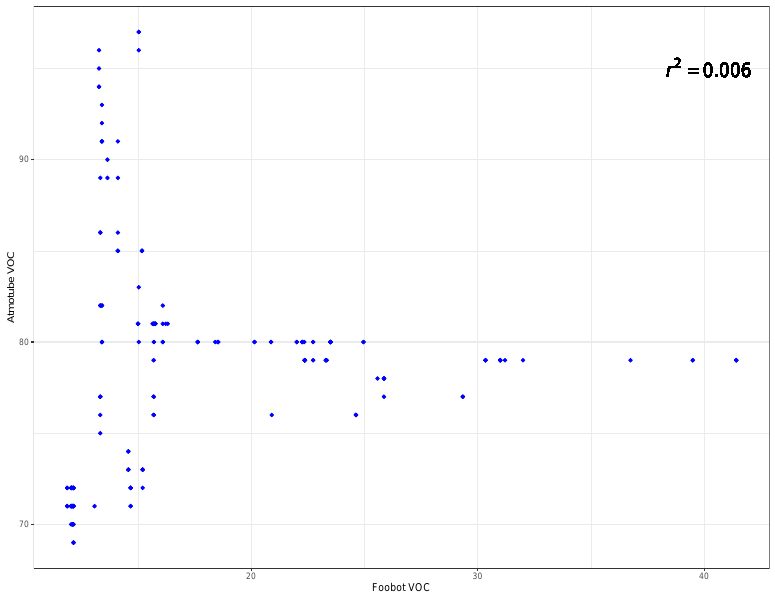
Figure 5. Indoor VOC Values from Atmotube and Foobot for